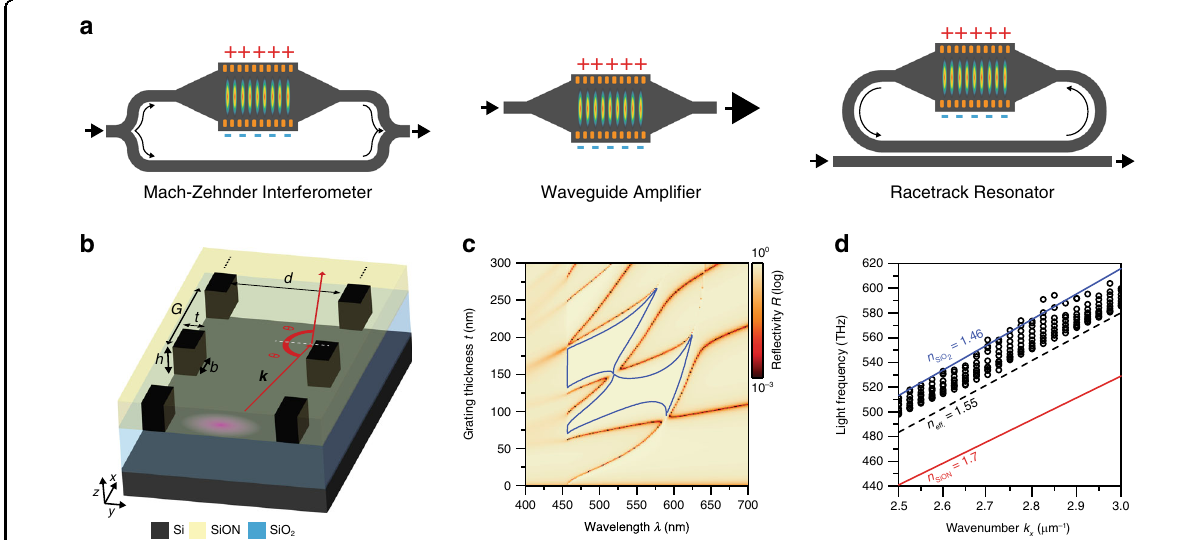
Fig. 1 Light re fl ection from an HCG and waveguiding. a Conceptual illustration of how HCGs could be integrated into a set of devices as absorptive electrodes to drive the respective active region. Here, the light (displayed as arrows) travels in standard passive waveguides and enters and exits the HCG sections (orange gratings) with the active material in between through adiabatic mode conversion tapers. b Basic geometry of an HCG waveguide with grating thickness t , period G , fi ll factor η = b / G and waveguide width d . Light with wavevector k at high incidence angle θ is re fl ected at the grating (red arrows). The pink area illustrates the cross-section of the HCG waveguide mode. c Re fl ectivity spectrum calculated with RCWA of a single HCG as the grating thickness t is varied while keeping other geometry parameters fi xed at η = 60%, G = 135 nm and θ = 80°. Blue contour lines enclose the regime where re fl ectivity R > 99% holds, showing that the high re fl ectivity is broadband (>100 nm in wavelength at t = 135 nm) and resilient to small grating thickness variations (±15 nm at a λ = 550 nm wavelength). d 3D FDTD simulated waveguide dispersion for E z - polarized light with the geometry parameters η = 60%, t = 135 nm, h = 220 nm and d = 5000 nm. Black circles show the different modes supported by the HCG waveguide. The red and blue lines indicate the SiON and SiO 2 light lines, respectively. The black dashed line corresponds to an effective index n eff =